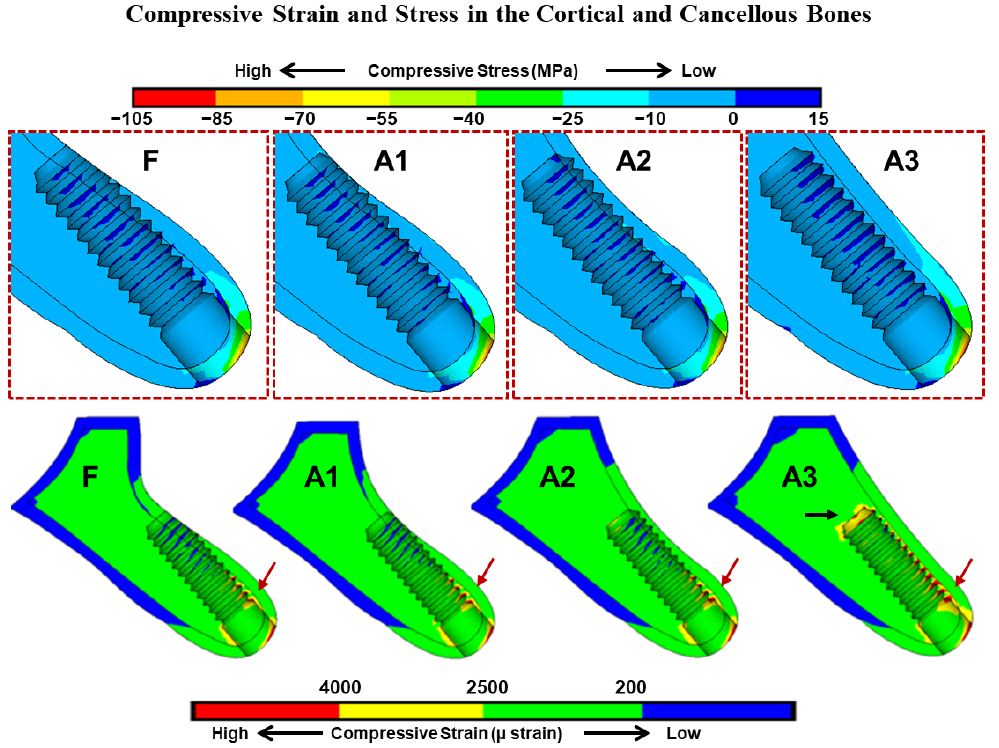
Figure 3. The effect of gradual augmentation of the facial bone defect and the exposure of apical threads on the compressive strain and stress generated in the cortical and cancellous bones. In the cortical bone, the maximum compressive stress and strain were shown at the facial cervical regions of all models. In cancellous bone, strain concentrations were observed at the first implant thread (red arrow), while in the A3 model, strain concentration was observed also at the implant apex (black arrow). Implant bed region in the fenestration (F) and augmented (A1–A3) models are enlarged (upper graphics). The red color contour represents the maximum strain and stress in each model.